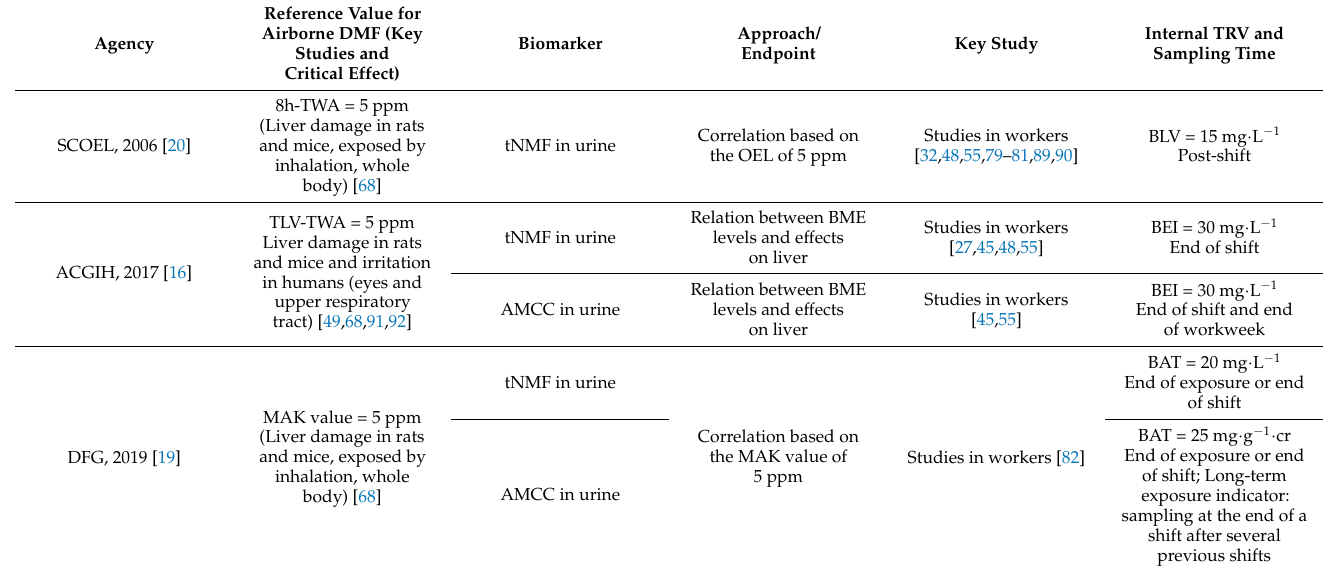
Table 4. Existing limit values for urine tNMF and AMCC in an occupational